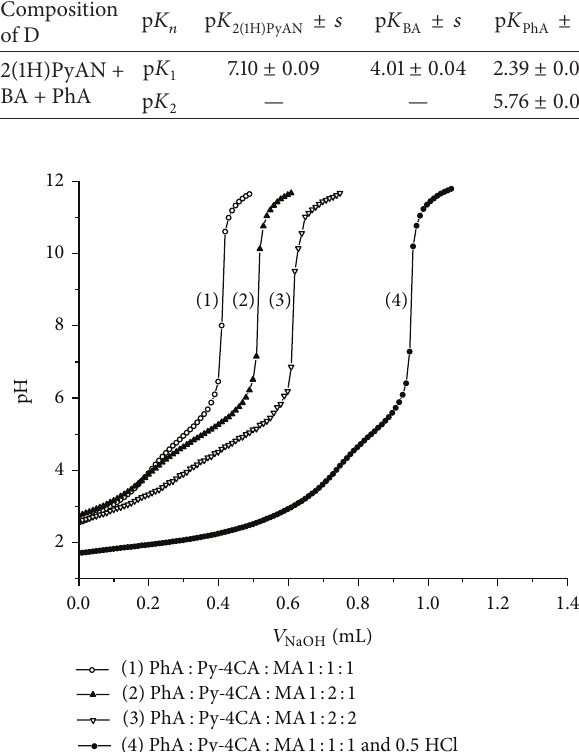
) obtained for the mixture NaOH